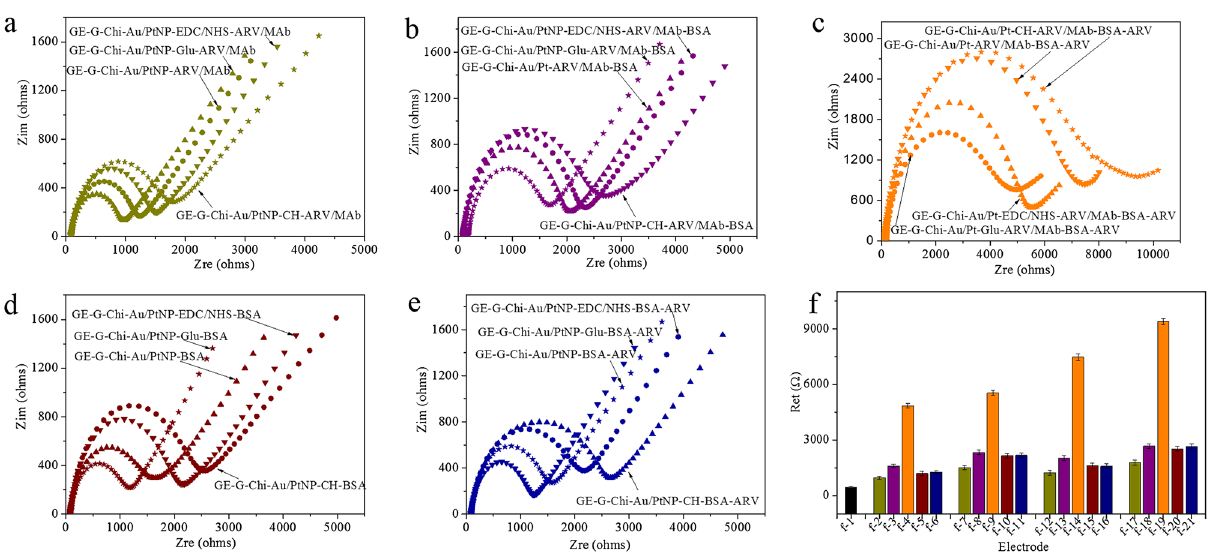
Figure 3. Nyquist plots for EIS characterization of electrodes after different modification steps in electrolyte (pH = 7.0) containing 5 mM [Fe(CN) 6 ] 3−/4− : ( a ) after ARV/MAb immobilization on GE-G-Chi-Au/PtNP, ( b ) after blocking with BSA, ( c ) after incubation with 10 6.82 EID 50 mL −1 ARV, ( d ) after blocking with BSA without ARV/MAb immobilization, ( e ) after incubation with 10 6.82 EID 50 mL −1 ARV without ARV/MAb immobilization; ( f ) R et from EIS characterization of electrodes at different modification steps in electrolyte (pH = 7.0) containing 5 mM [Fe(CN) 6 ] 3−/4− : (f-1) GE-G-Chi-Au/PtNP, (f-2) GE-G-Chi-Au/PtNP-Glu-ARV/MAb, (f-3) GE-G-Chi-Au/ PtNP-Glu-ARV/MAb-BAS, (f-4) GE-G-Chi-Au/PtNP-Glu-ARV/MAb-BAS-ARV, (f-5) GE-G-Chi-Au/PtNP- Glu-BAS, (f-6) GE-G-Chi-Au/PtNP-Glu-BAS-ARV, (f-7) GE-G-Chi-Au/PtNP-EDC/NHS-ARV/MAb, (f-8) GE-G-Chi-Au/PtNP-EDC/NHS-ARV/MAb-BSA, (f-9) GE-G-Chi-Au/PtNP-EDC/NHS-ARV/MAb-BSA-ARV, (f-10) GE-G-Chi-Au/PtNP-EDC/NHS-BSA, (f-11) GE-G-Chi-Au/PtNP-EDC/NHS-BSA-ARV, (f-12) GE-G- Chi-Au/PtNP-ARV/MAb, (f-13) GE-G-Chi-Au/PtNP-ARV/MAb-BSA, (f-14) GE-G-Chi-Au/PtNP-ARV/ MAb-BSA-ARV, (f-15) GE-G-Chi-Au/PtNP-BSA, (f-16) GE-G-Chi-Au/PtNP-BSA-ARV, (f-17) GE-G-Chi-Au/ PtNP-CH-ARV/MAb, (f-18) GE-G-Chi-Au/PtNP-CH-ARV/MAb-BSA, (f-19) GE-G-Chi-Au/PtNP-CH- ARV/MAb-BSA-ARV, (f-20) GE-G-Chi-Au/PtNP-CH-BSA, (f-21) GE-G-Chi-Au/PtNP-CH-BSA-ARV. Error bar = RSD (n =